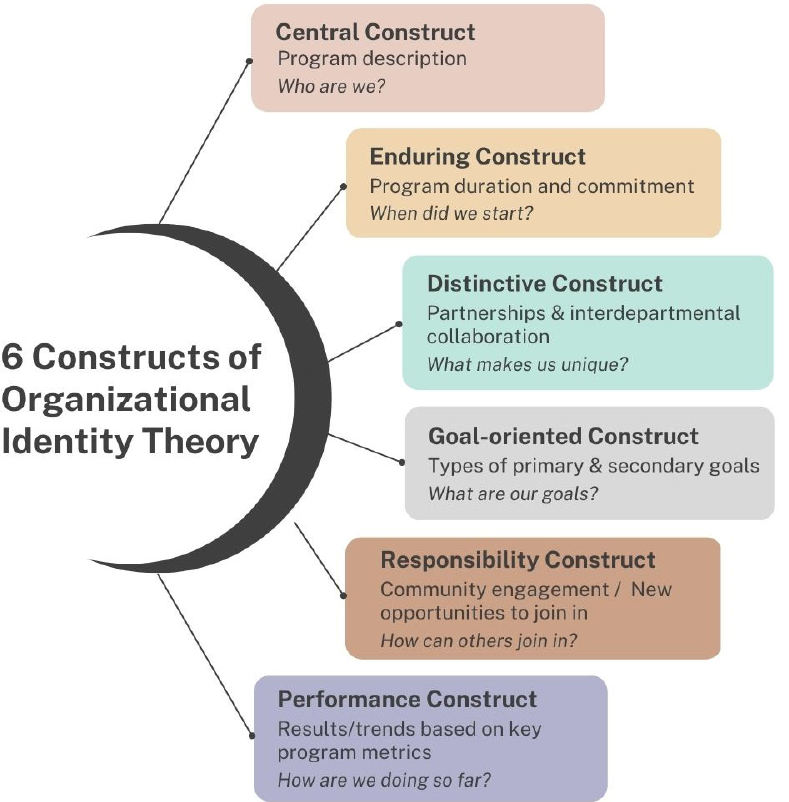
Figure 2. Descriptions and important components of the six constructs of organizational identity